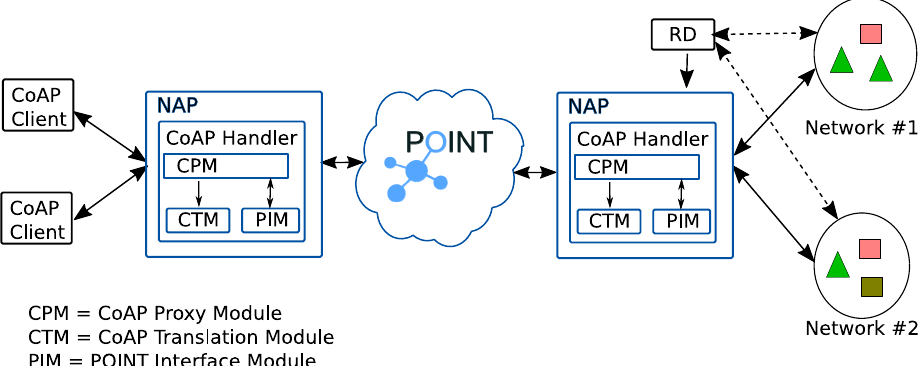
Figure 2. An example of CoAP over ICN reference architecture. On the right there are Things offering resources. Each resource is specified by a color and also by shape. On the left there are the CoAP